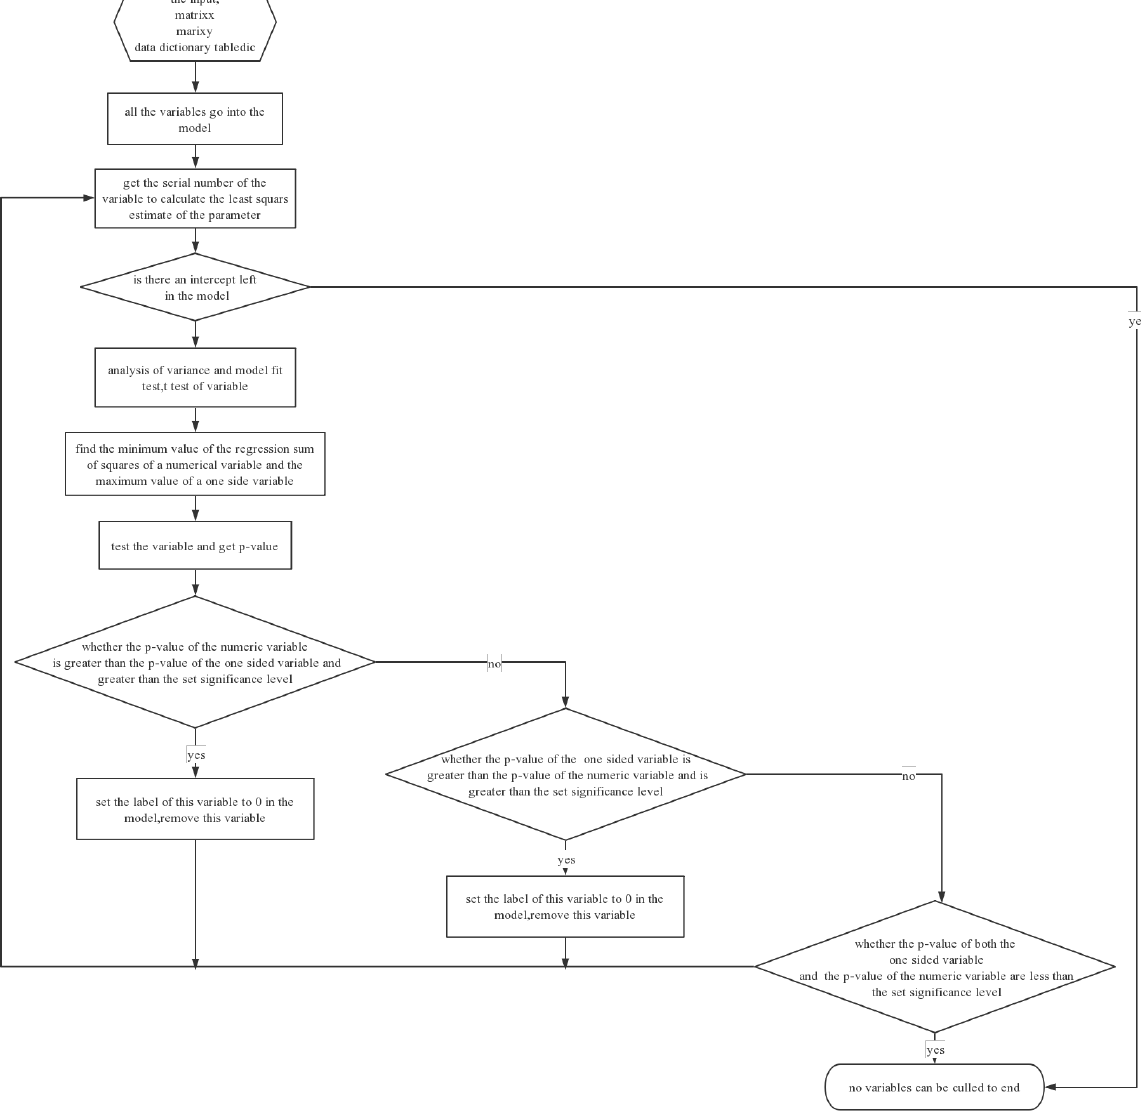
Fig. 1 Operation flow